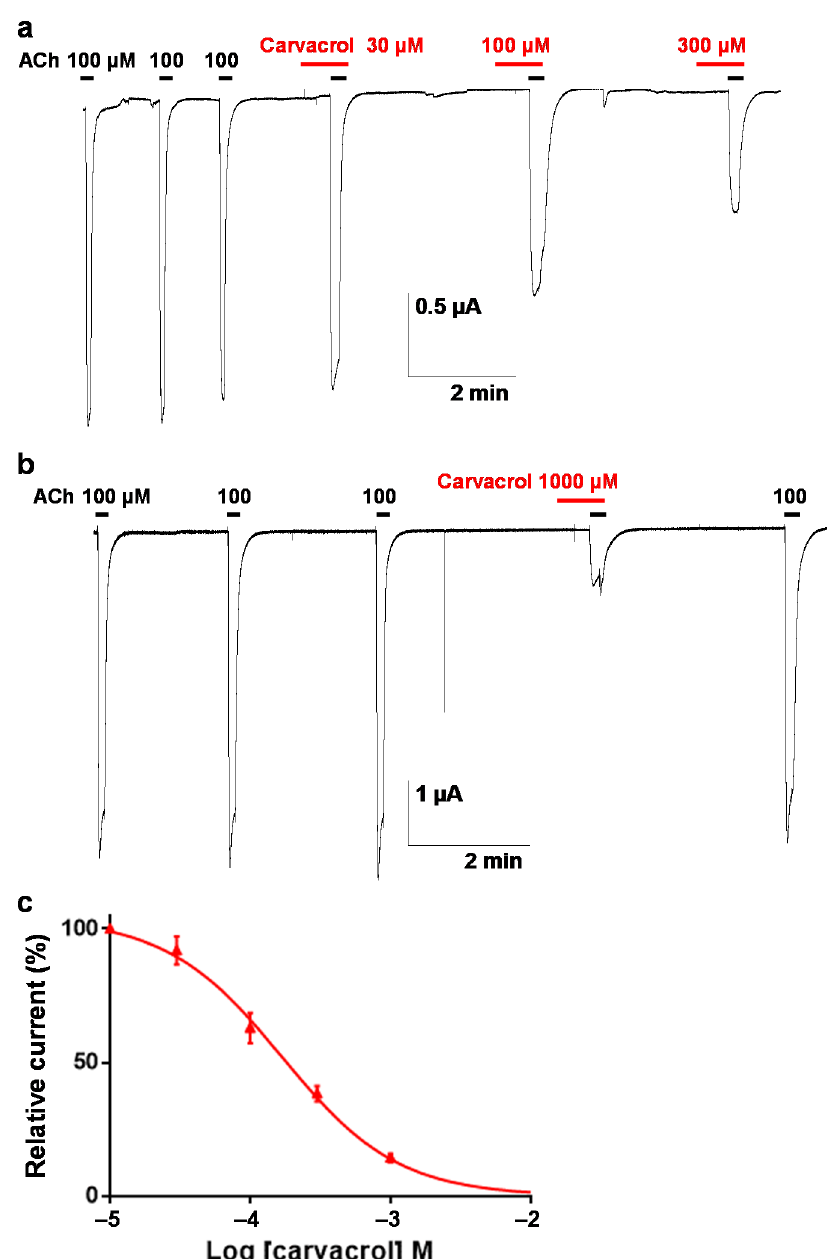
Figure 4. Concentration–inhibition relationship of carvacrol on the Parascaris sp. ACR-26/27 M- AChR expressed in Xenopus oocytes. Representative current traces for single oocytes challenged with acetylcholine (ACh) in the presence of increasing concentration of carvacrol from 30 to 300 ( a ) and 1000 µM ( b ). The concentrations of ACh and carvacrol (µM) are indicated above each trace. ACh was applied for 10 s (black bars), and carvacrol was applied for 20 s (red bars). ( c ) Concentration–inhibition response curve of carvacrol. All responses are normalized to 100 µM ACh. Results are shown as the mean ± SE ( n = 7).